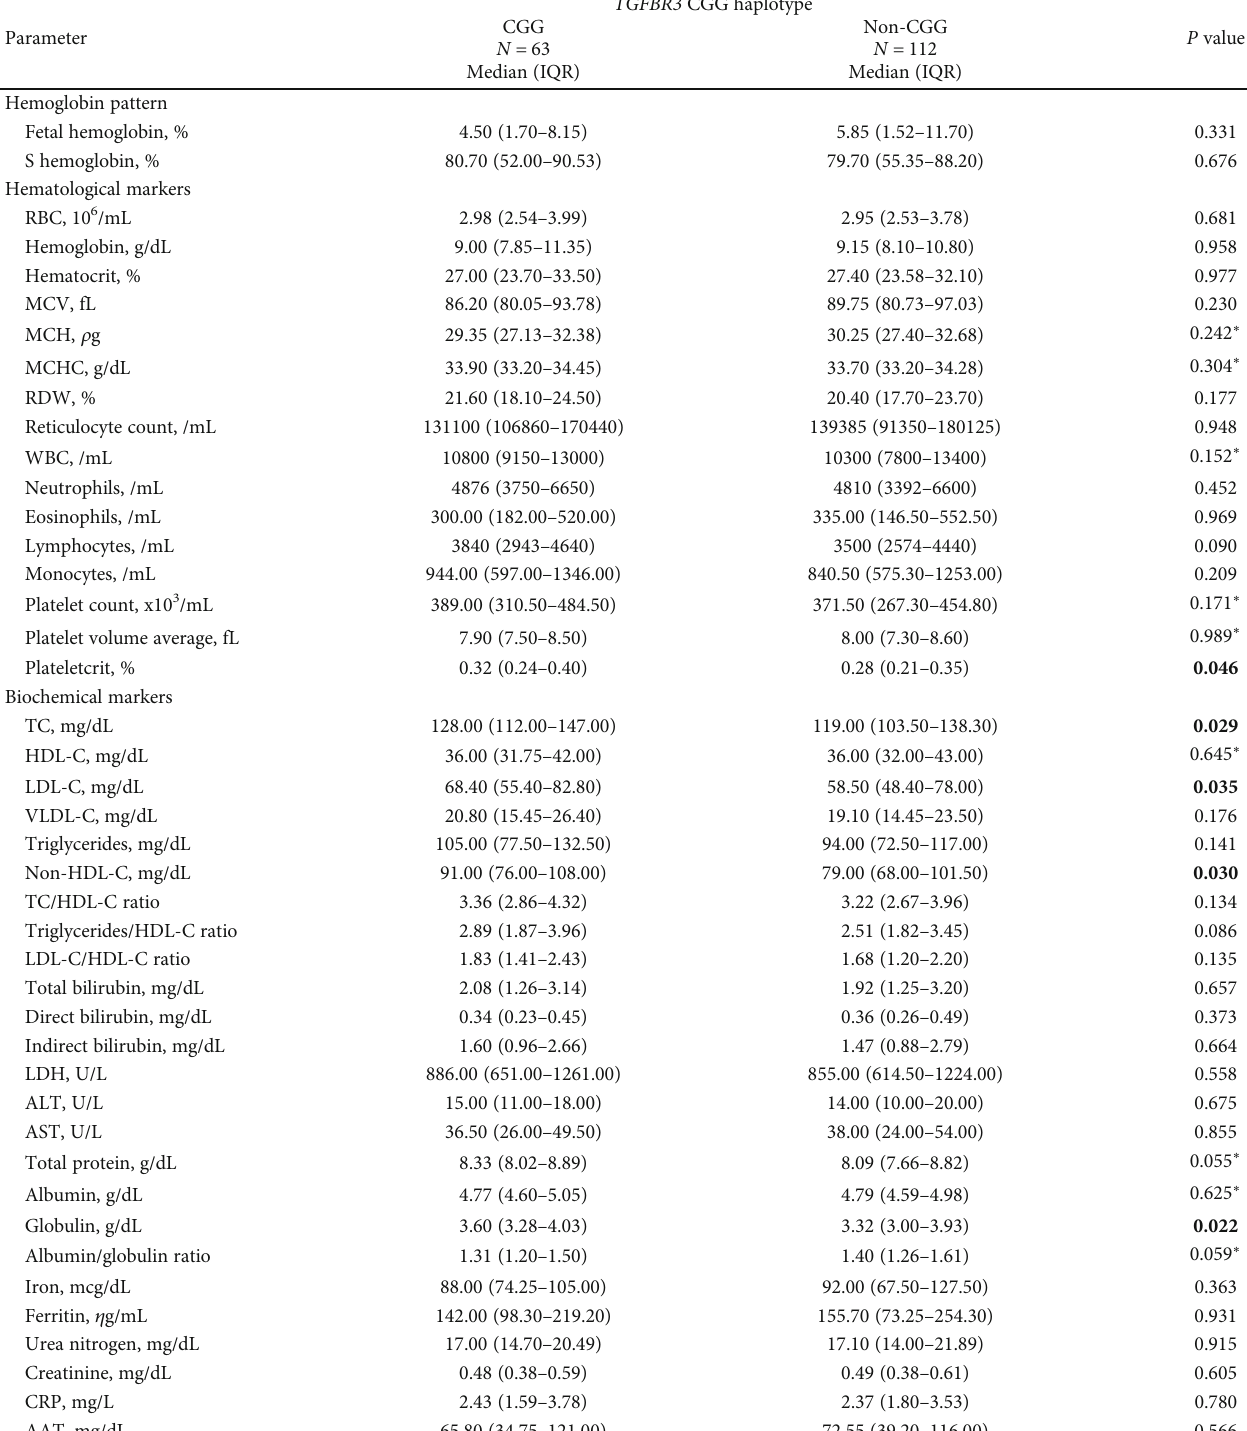
Table 7: Association of TGFBR3 CGG haplotype with laboratory